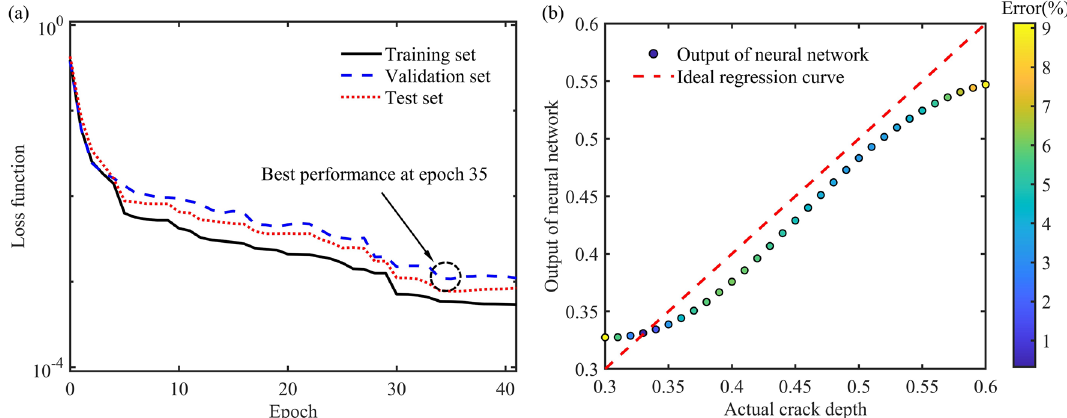
Figure 13 Training and test results of the RBF network when the crack is located at the end of the rotor system: ( a ) Loss function curve, ( b ) Regression